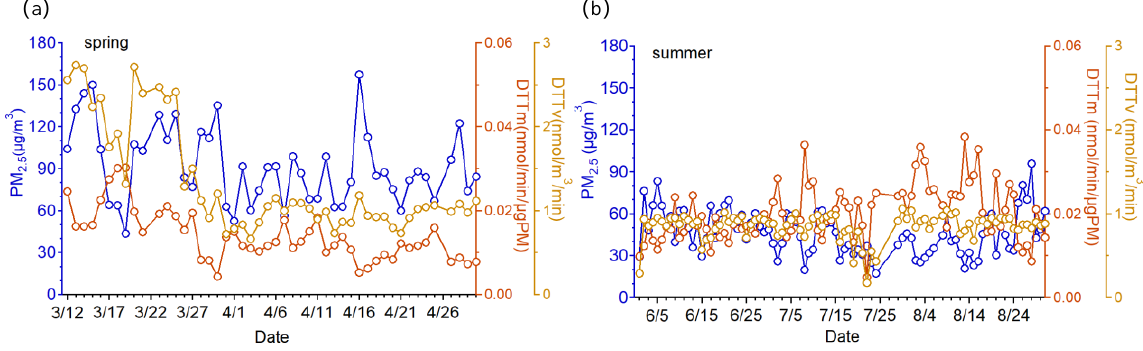
Figure 2. Time series of volume- and mass-normalized DTT at the sampling site during ( a ) spring and ( b ) summer.